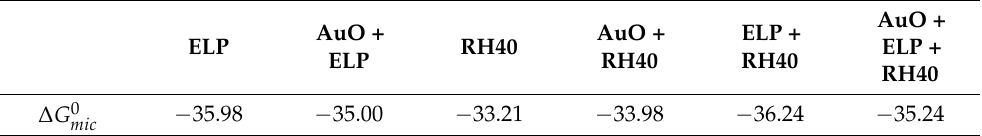
Table 5. The values of ∆ G 0 (kJ/mol) of AuO, ELP, RH40 and their mixtures determined on the mic basis of CMC1 values (Table